Question: Sum up the contents of this chart in one sentence.
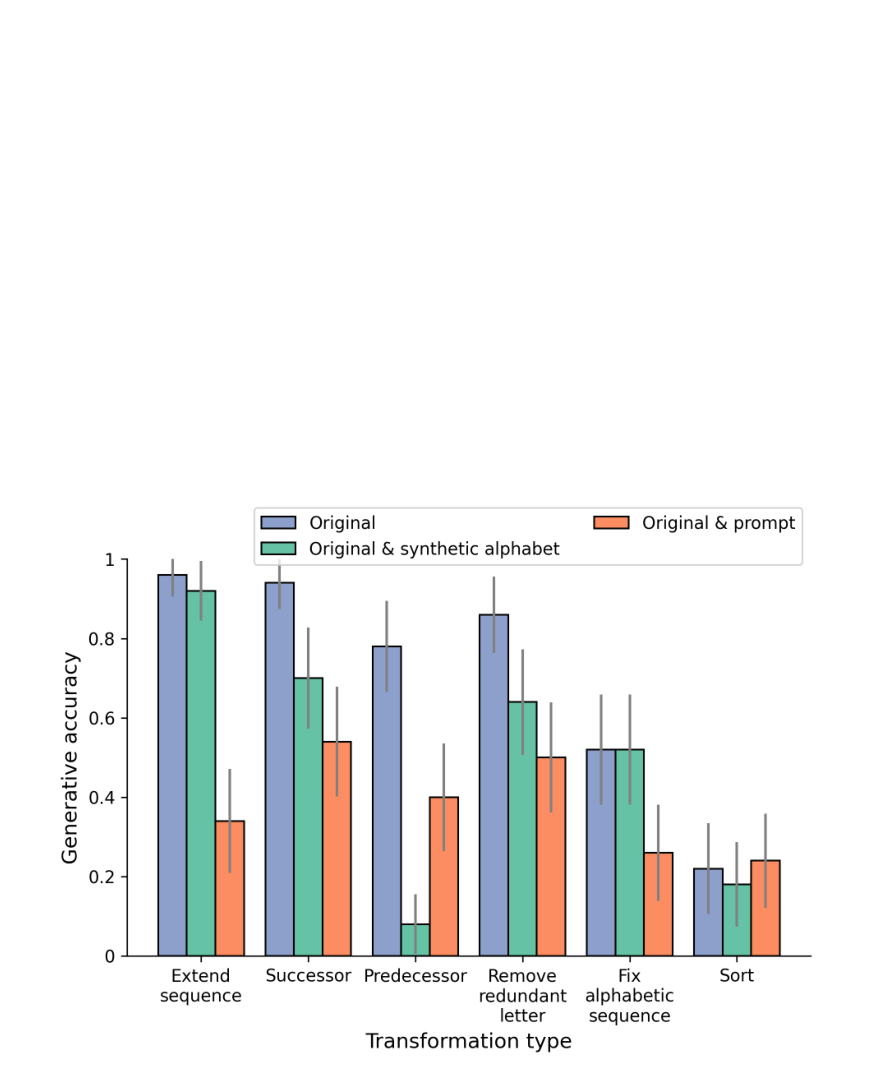
Answer: Counterfactual comprehension check. Comparison of GPT-3 performance on zero-generalization letter string problems between original tasks (blue) and the only marginally modified tasks involving a synthetic alphabet without modification of the interval size (green) and a modified prompt without modified string sequence (orange). The accuracy on modified tasks is lower than on the original ones but, greater than 0.2 except for ‘remove redundant letter’ and ‘sort’ involving the synthetic alphabet. The figure and the order of the transformation types correspond to Figure 6b in the original paper. These results reflect an average performance for N=50 instances.